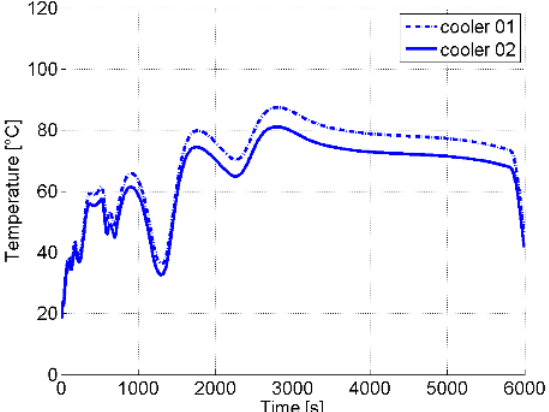
Fig. 9. Temperature behind the coolers in a course of time.